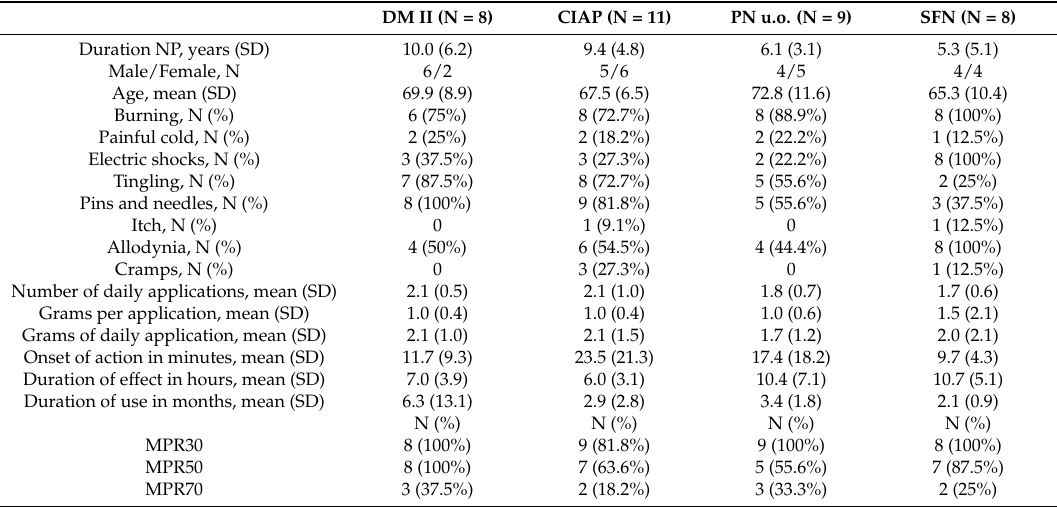
Table 4. Characteristics and effect of phenytoin 10% cream in the four most seen